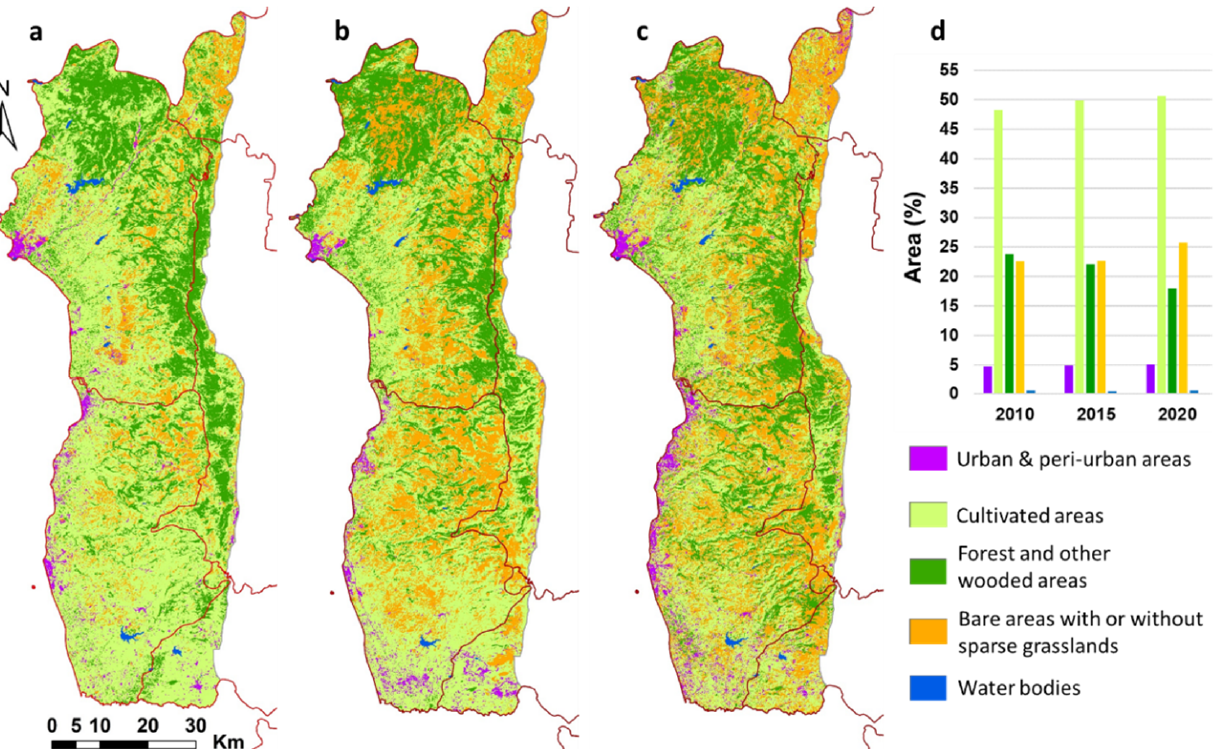
Figure 5. LULC in the Syrian coast region for 2010 ( a ), 2015 ( b ), and 2020 ( c ). The area (in %) of LULC categories after computing adjusted area estimates is given in ( d ). Table 6. Area estimates in hectares (ha) and percentage share (%) of each LULC category between 2010 and 2020 (after computing adjusted area estimate).